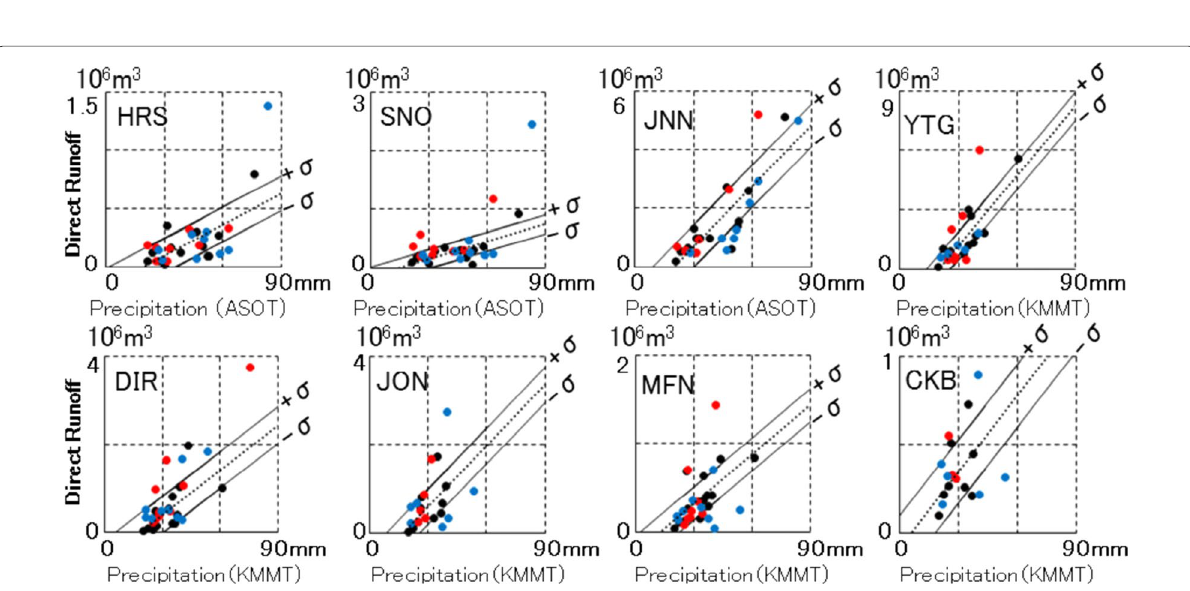
Fig. 6 Temporal change in streamflow response to precipitation. Solid black circles indicate the response from January 1, 2014, to April 13, 2016. Solid red circles indicate the response from April, 14, 2016, when the 2016 Kumamoto earthquake started, to December 31, 2016. Solid blue circles indicate the response from January 1, 2017, to December 31, 2017. Black dotted lines indicate the average correlation between precipitation and direct runoff from January 1, 2014, to April 13, 2016. σ is the standard deviation of the average correlation during the same